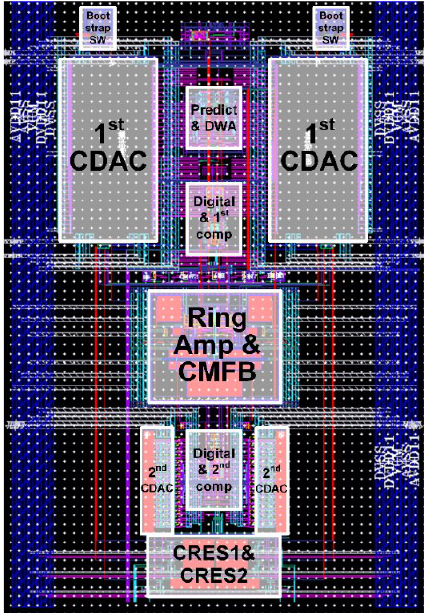
Figure 11. Proposed ADC core layout.